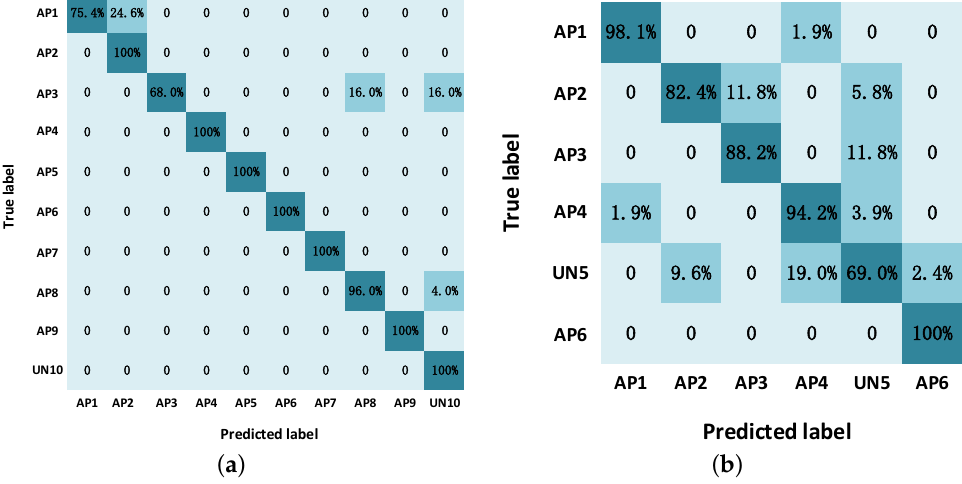
Figure 10. The confusion matrix when leave-one-appliance-out validation is used. ( a ) The confusion matrix on REDD. ( b ) The confusion matrix on